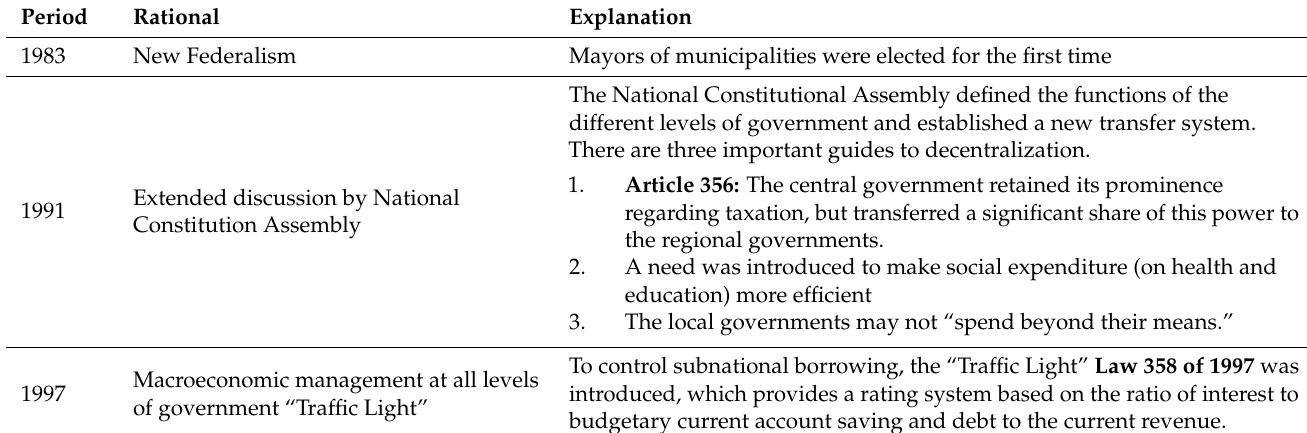
Table 1. Major Decentralization Reforms in